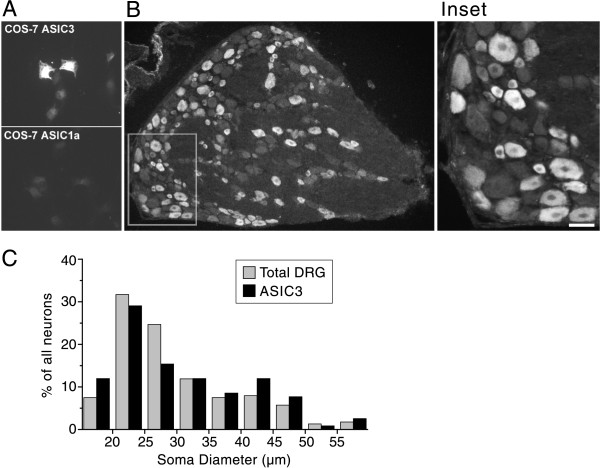
Immunocytochemical localization of ASIC3 in rat sensory neurons. A, ASIC3 antibody labeled COS-7 cells transfected with ASIC3 (top), but not those transfected with ASIC1a (bottom). It also failed to label cells transfected with ASIC1b and ASIC2a (not shown); ASIC2b and ASIC4 were not tested. B, ASIC3 immunoreactivity in a section of L5 DRG. Less than half of neurons are labeled and no non-neurons are labeled. Note the presence of both small and large labeled neurons (inset). Scale bar, 40 μm. C, Size-frequency distribution of ASIC3-positive neurons (black) and of all neurons (grey) from the L5 DRG. ASIC3+ cells are present in all size bins. 3345 neurons (12–15 sections from 3 rats) were counted, of which 1359 (40%) were ASIC3-positive.